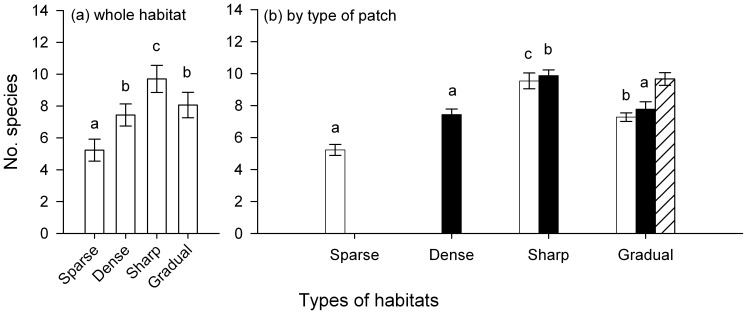
Effects of composition of experimental landscapes on numbers of speciesMean (±SE) numbers of species in experimental landscapes with different composition (Sparse, Dense, Sharp and Gradual). Numbers of species are averaged across 2 sites and 3 replicate experimental landscapes. In (b), bars with different patterns indicate numbers of species in different types of turfs in landscapes of different composition: sparse (clear), dense (solid) and intermediate (striped) turfs. Letters indicate significant differences between means (SNK at P<0.05; analyses in Table 2.